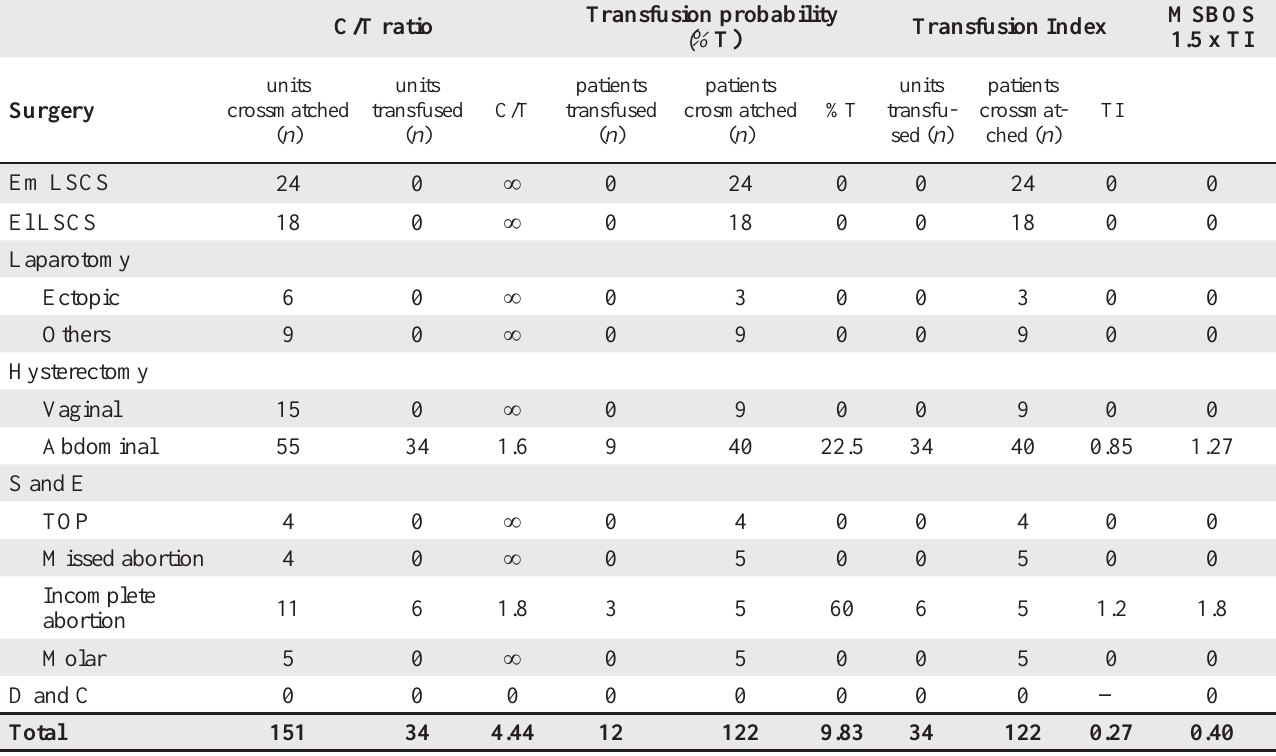
Table 3 : Blood utilization